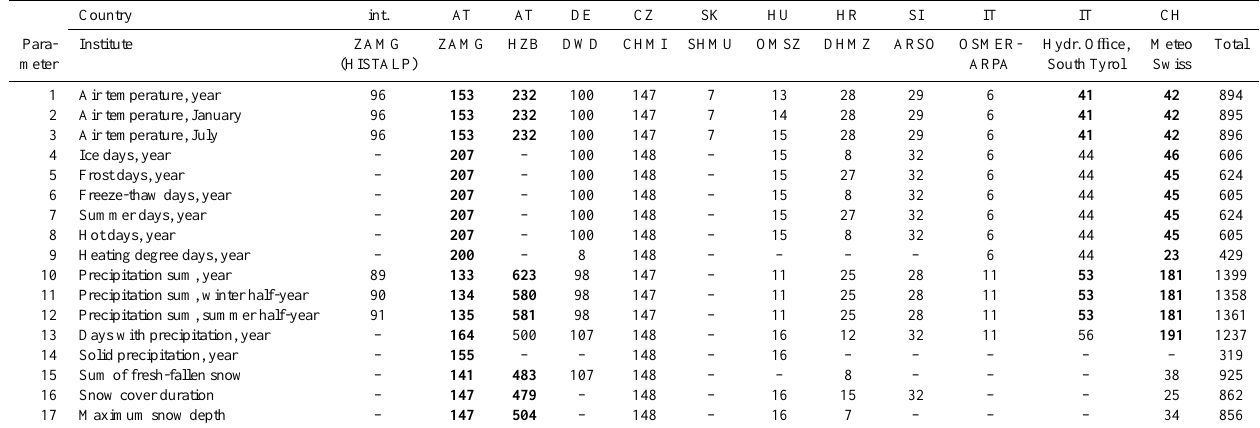
Table 1. The final data collection according to climate parameter, country of origin and data provider. Bold station numbers denote gap-filling in the respective subdataset.